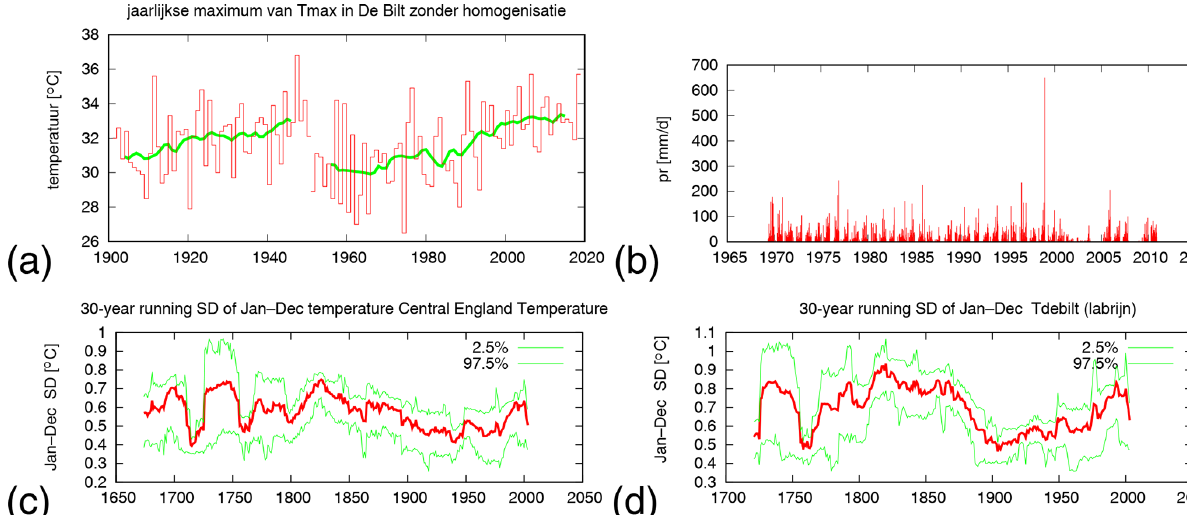
Figure 3. Examples of problems with time series, reproduced on the Climate Explorer at https://climexp.knmi.nl (last access: 31 Octo- ber 2018). (a) A 2 ◦ C inhomogeneity in the highest maximum temperature of the year, T Xx , in 1950–1951 (De Bilt before homogenization; Brandsma, 2016), (b) precipitation at a station illustrating displaced decimal points giving an unrealistic extreme of 660mmd − 1 that does not show up in satellite data, disaster databases or newspapers, and a factor 10 the other way in 2001–2003, (c) 30-year running standard deviation of annual mean Central England Temperature (Manley, 1974; King et al., 2015), and (d) the same for the De Bilt temperature (van Engelen and Nellestijn,